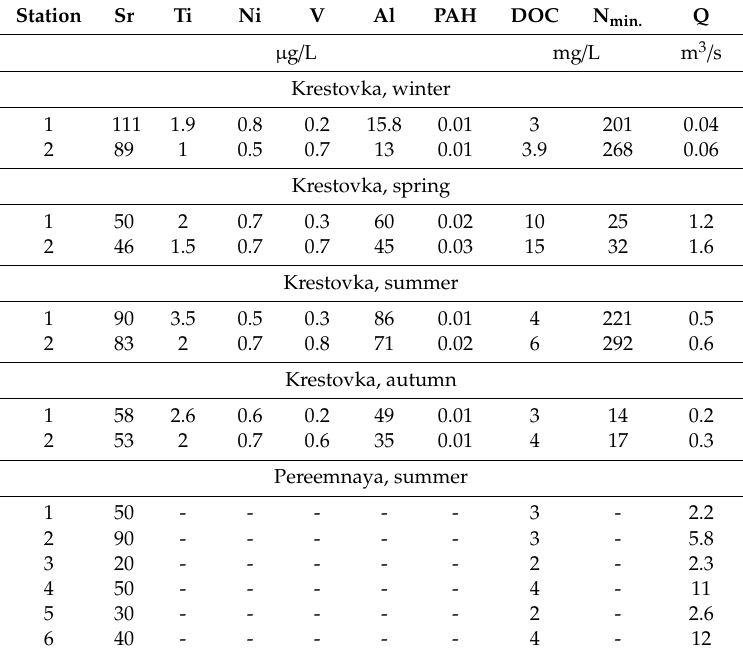
Table 1. Average chemical composition and water discharge of small tributaries of Lake Baikal. DOC: dissolved organic carbon; N min. : mineral nitrogen; PAH: polycyclic aromatic